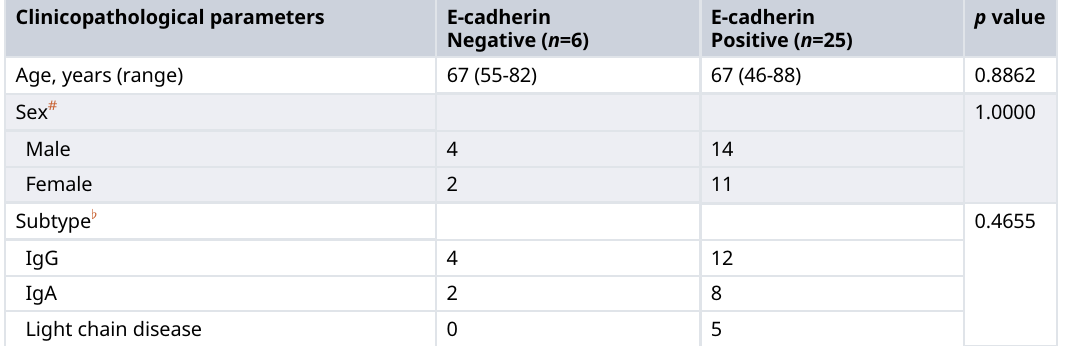
Table 1. Relationship between E-cadherin expression and clinicopathological parameters at